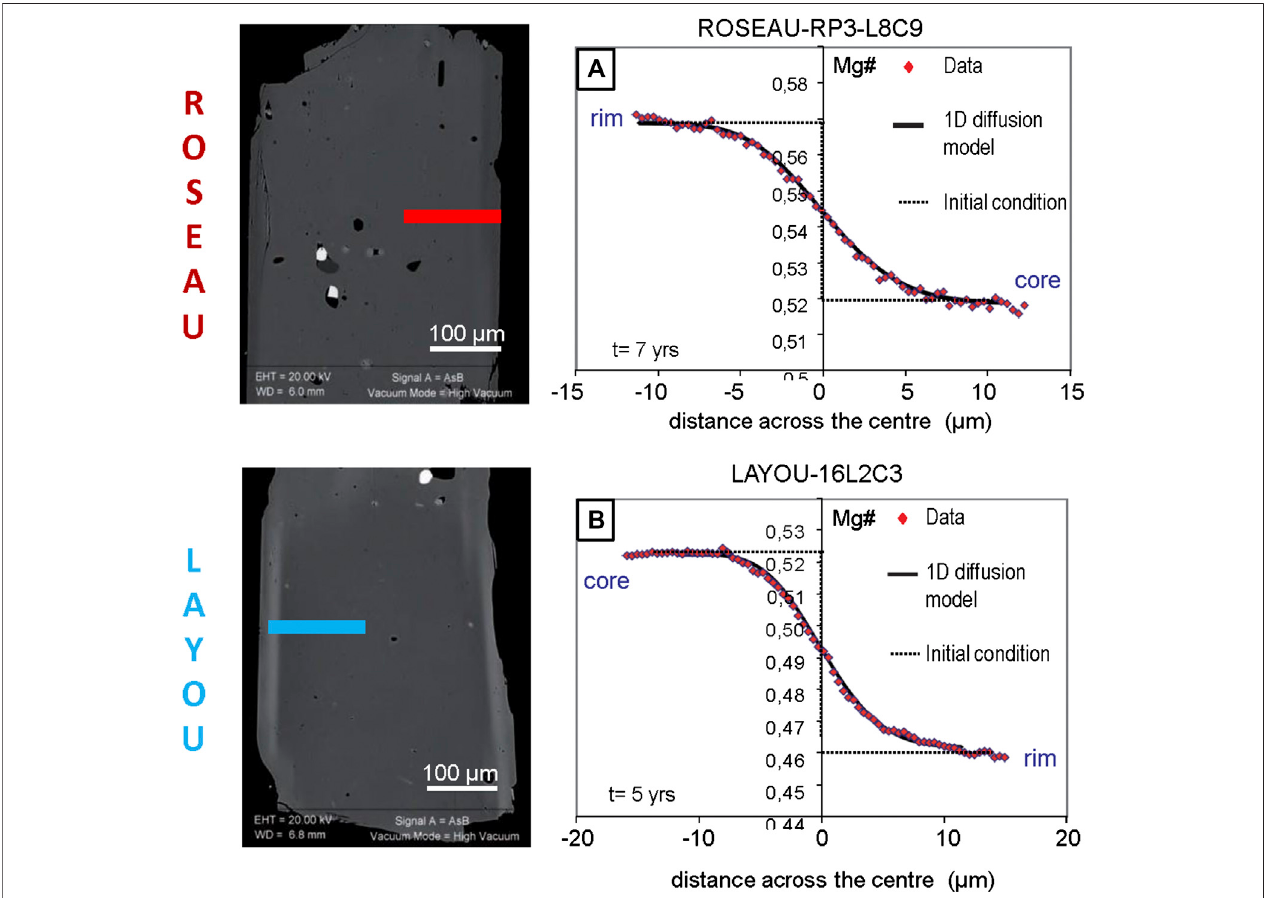
FIGURE 5 | Examples of two modeled diffusion pro fi les for Roseau (A) and Layou (B) . Red/blue line on each Back-Scattered Electron (BSE) image (left) indicates thepro fi leposition[ElectronProbeMicroanalyses(EPMA)fullpro fi le]ontherespectiveorthopyroxene(Roseau,Layou).Diffusionpro fi les(right)arereportedasMg#[Mg/ (Mg + Fetot)], as a function of the distance from the center of the pro fi le (in µm). Red rhombs: EPMA and BSE greyscale intercalibrated data; black line: diffusion model. Time (t) is given for each pro fi le. The initial conditions are given by the dashed line (staircase pro fi le).